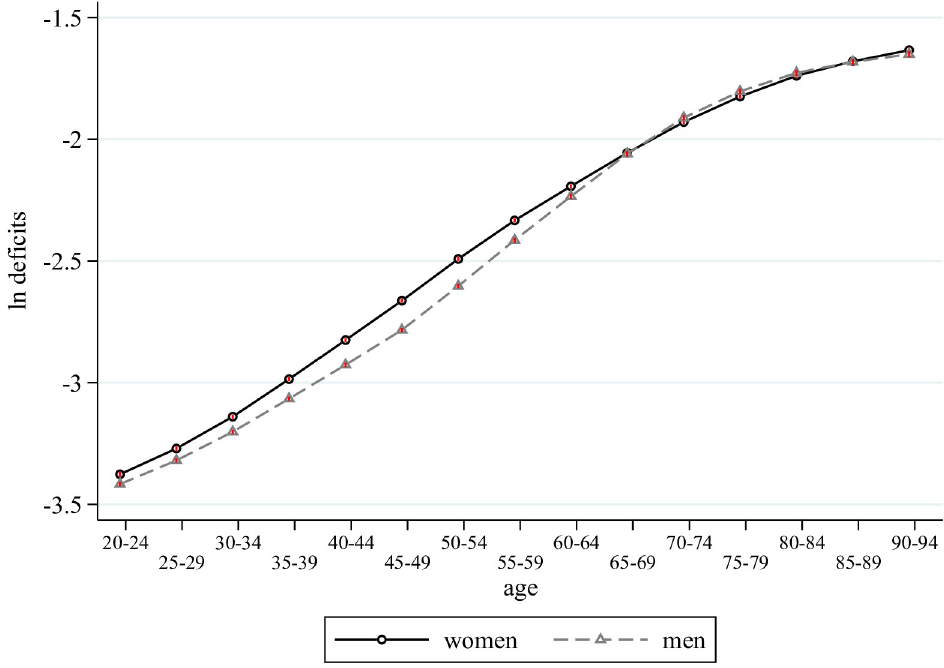
Fig 1. Average period life cycle deficits of women and men, 1990–2019. Notes: This figure plots the estimates from regressing log deficits on a full set of age-group dummies (omitting the regression constant) by gender, using data for all countries in the world and all periods (1990, 1995, ‥ 2019), which corresponds to the average of log deficits for each age across countries and period. The small red vertical lines indicate 95 percent confidence bands.